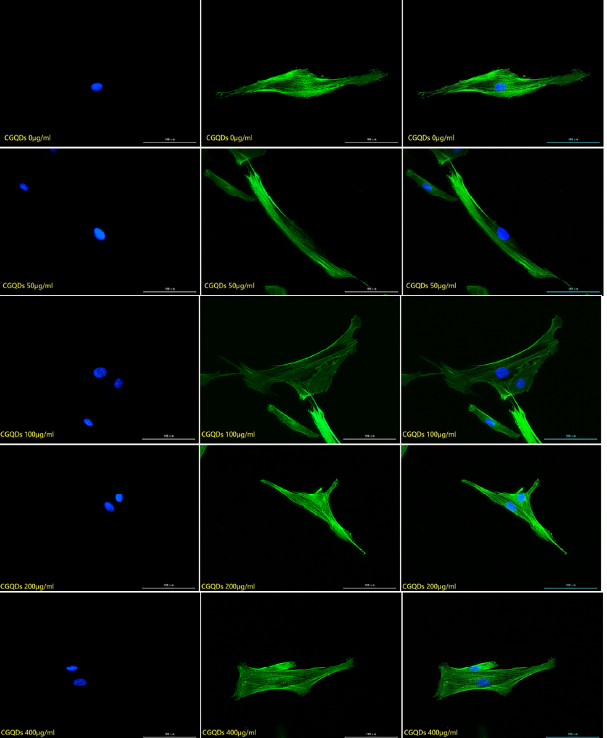
Figure 6. The fluorescence map of FITC-DAPI cytoskeleton staining of HSFs labeled with CGQDs, scale bar: 100 μ m.